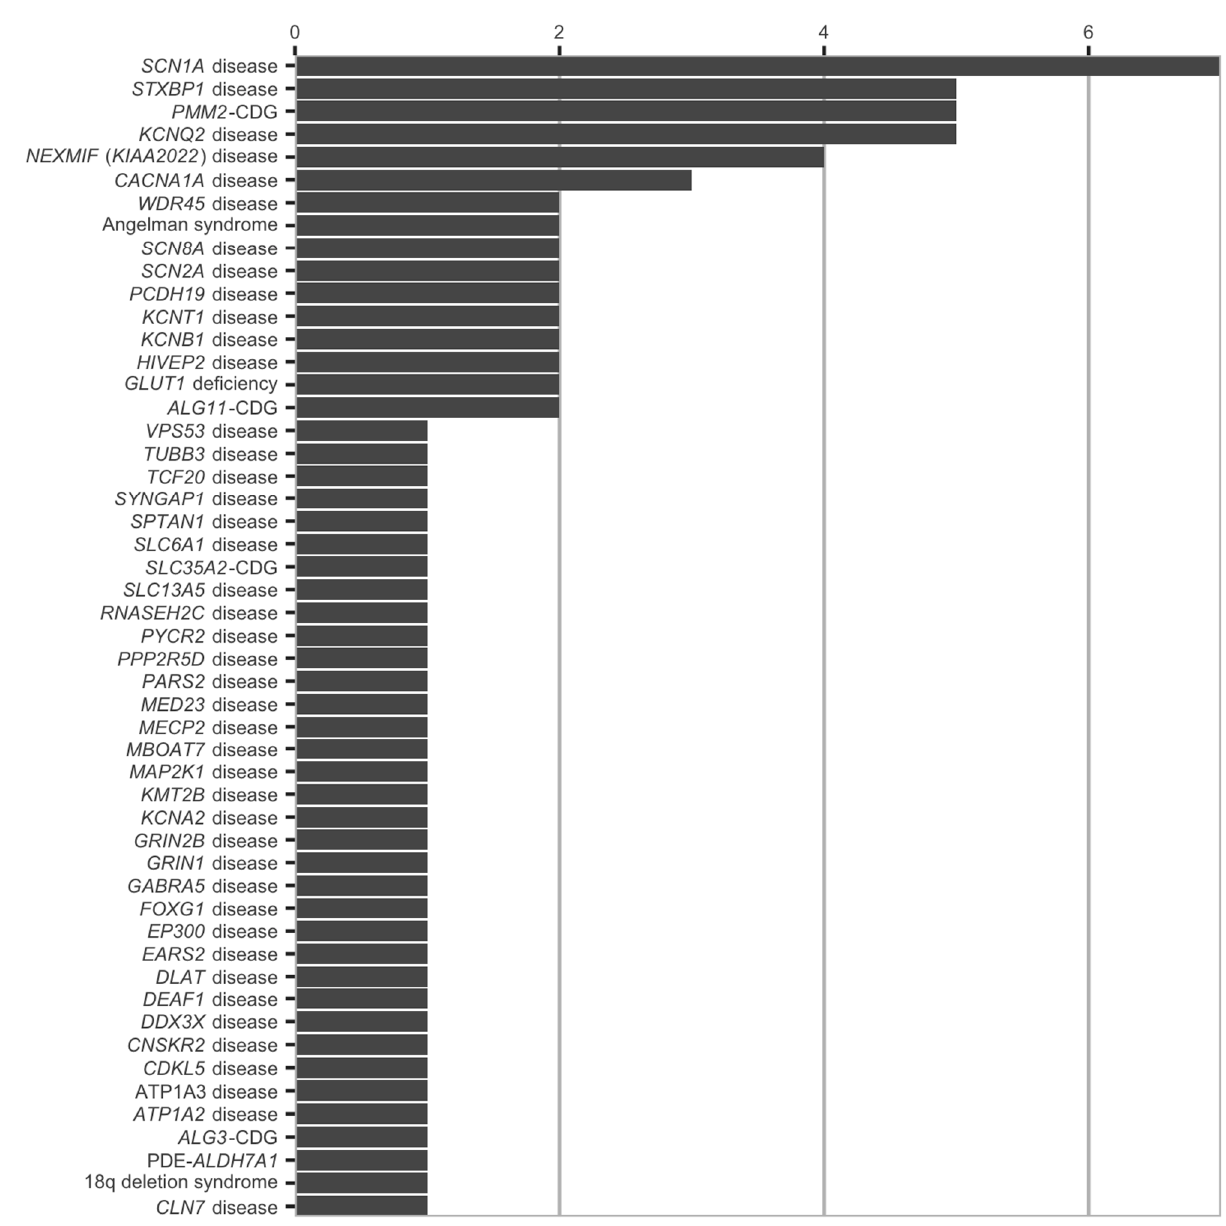
Figure 2. All genetic diagnoses and the number of patients for each genetic disease are depicted in Figure 2.